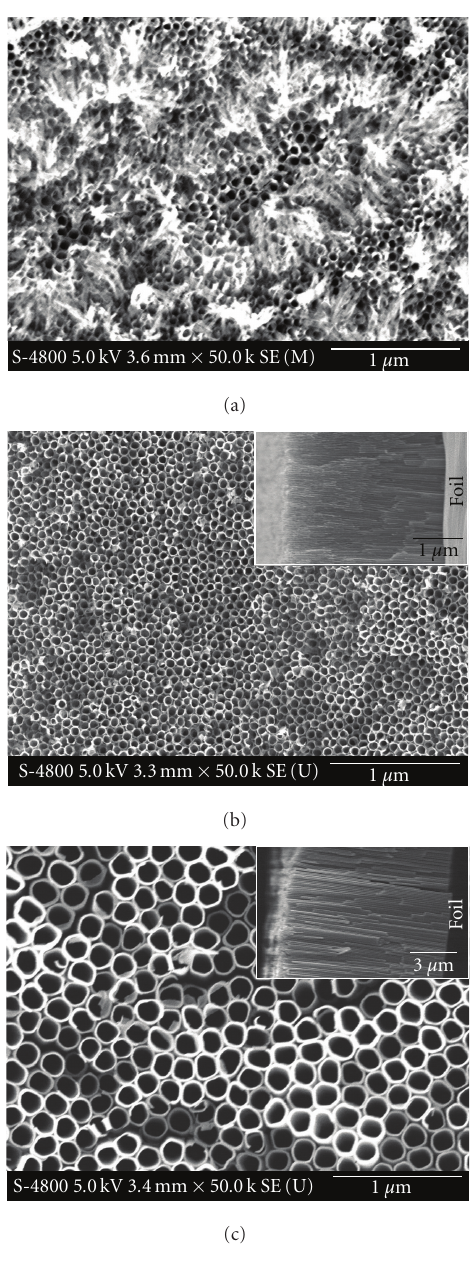
Figure 1: FE-SEM images of titania nanotube arrays (TNAs) formed by anodization for 5 h in electrolyte solutions: (a) without H 2 SO 4 at 20V, (b) with H 2 SO 4 at 20V, and (c) with H 2 SO 4 at 50V. Insets show cross-sectional